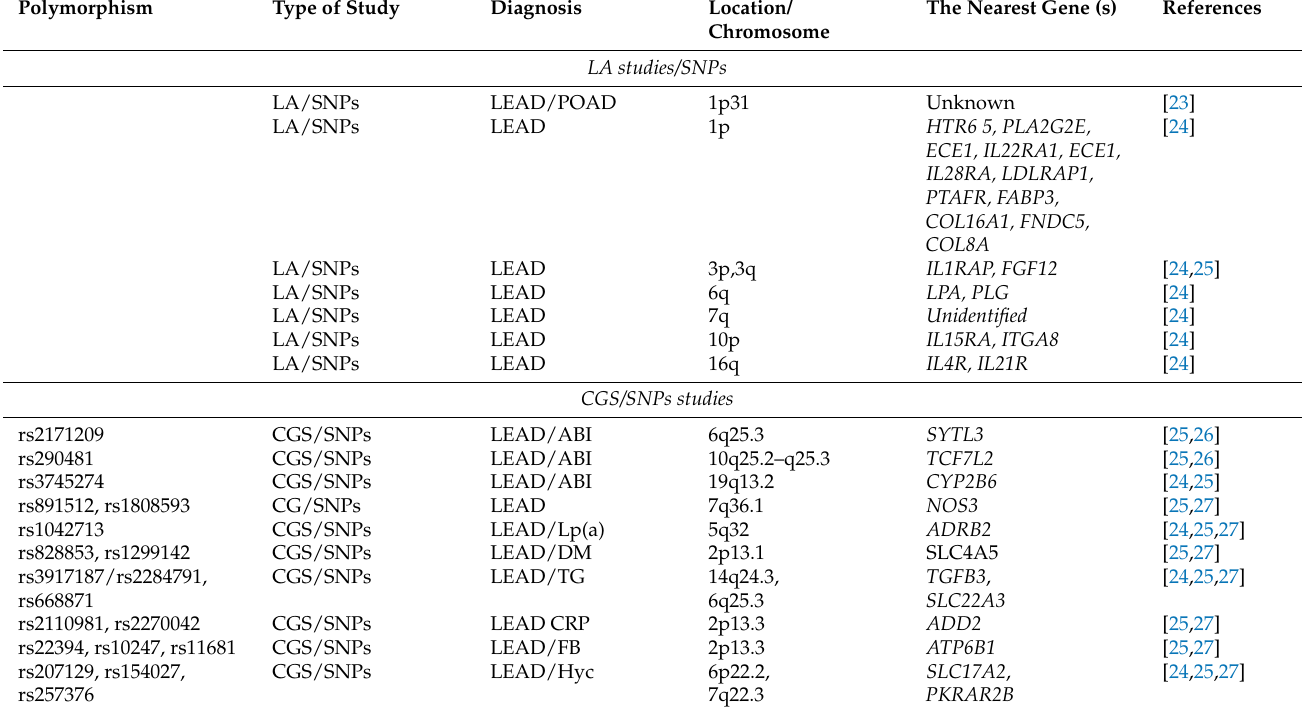
Table 1. Genetic Etiology of Lower Extremity Peripheral Artery